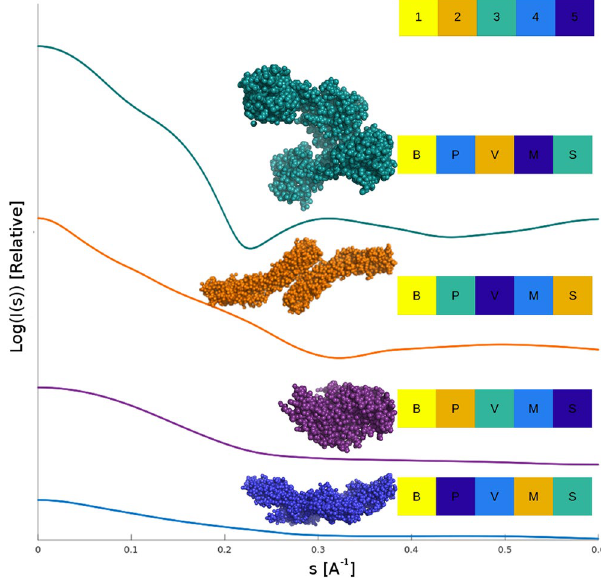
Figure 1. MM determination methods perform differently on different proteins. Four CRYSOL simulated SAXS profiles (Log of relative intensity against s) of proteins with different shape, the profiles are offset for clarity. These cases illustrates the variation in MM estimates of the various methods. Here each of MM Qp (P), V c (V), MoW (M) and Size&Shape (S) at least once provide a MM estimate with the smallest (yellow) and the largest (dark blue) relative error, respectively. However, the estimate provided by the Bayesian inference is consistently the